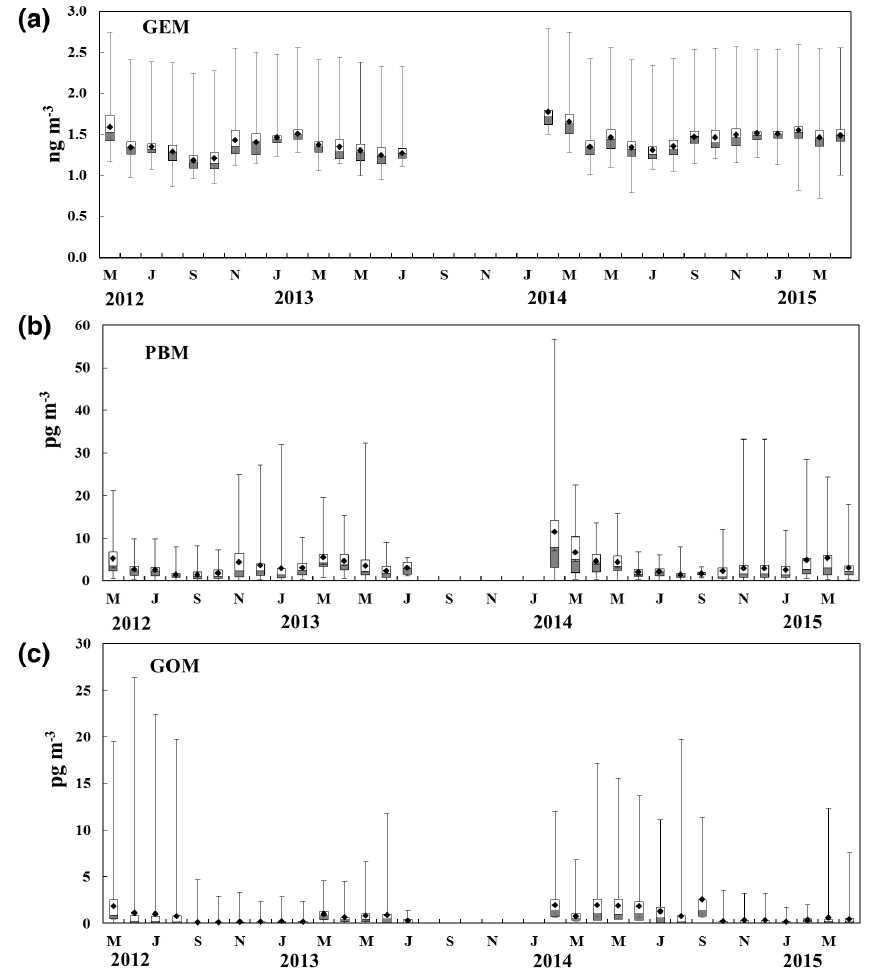
Figure 2. Box plots of measured (a) GEM, (b) PBM and (c) GOM at Råö/Rörvik from May 2012 to July 2013 and from February 2014 to April 2015. Diamonds show average values. Upper and lower boxes show 75 and 25% percentiles respectively with median values in between. Upper and lower whisker bars show maximum and minimum